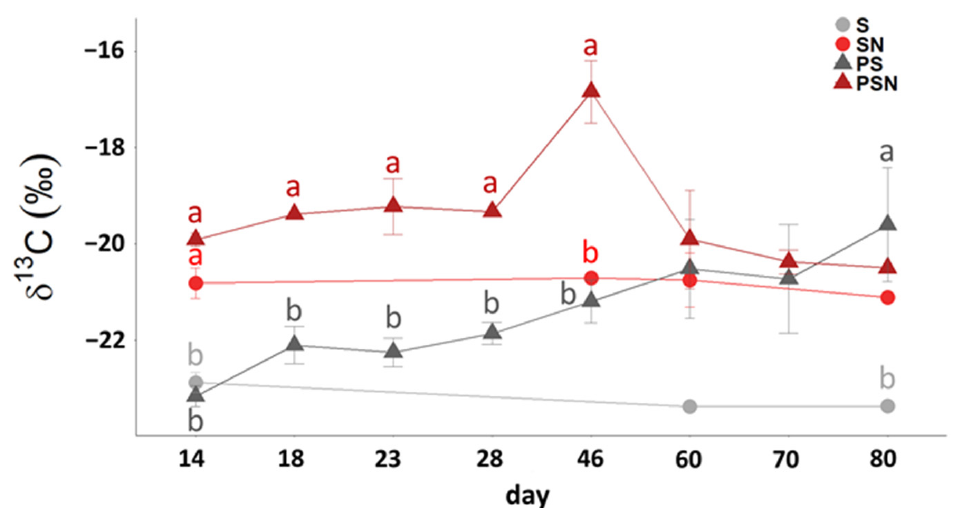
Figure 3. Dynamics of δ 13 CO 2 -C during experiment: S indicates control soil without N addition, SN—control soil with N addition, PS—PBSA-amended soil without N addition and PSN—PBSA- amended soil with N addition. The letters indicate significant differences between treatments at the corresponding time point.